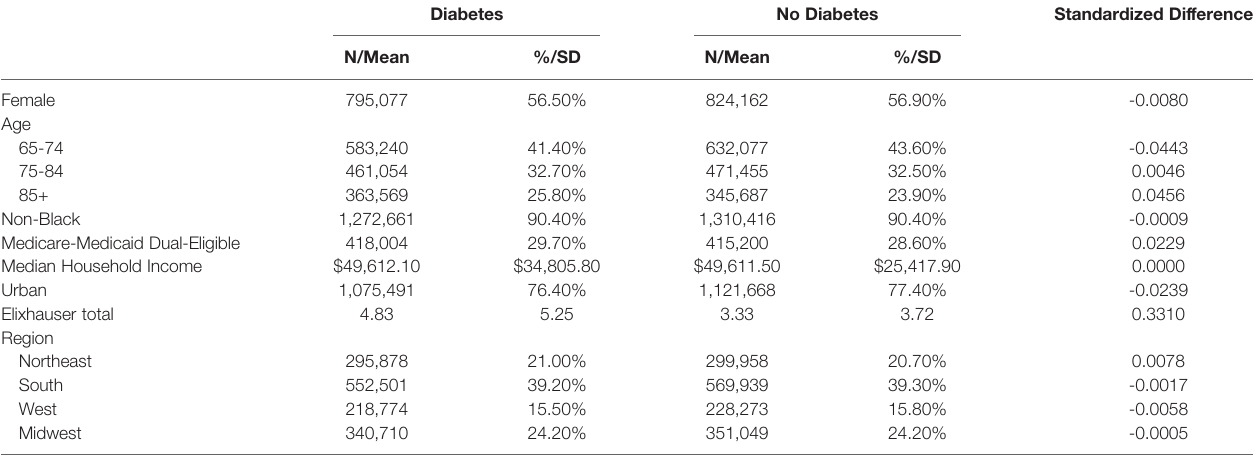
TABLE 2 | Weighted demographic characteristics of Medicare bene fi ciaries with a diagnosis of COVID-19 in the 2020 claims data.